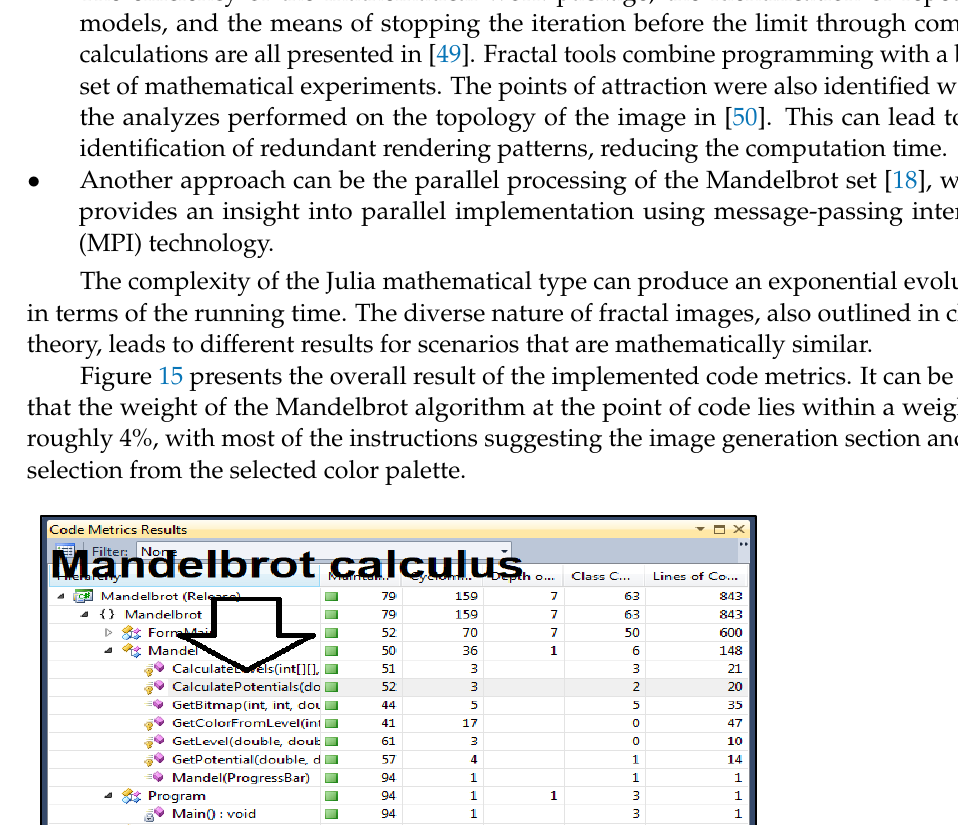
Figure 15. Code metric results for the Mandelbrot calculus.